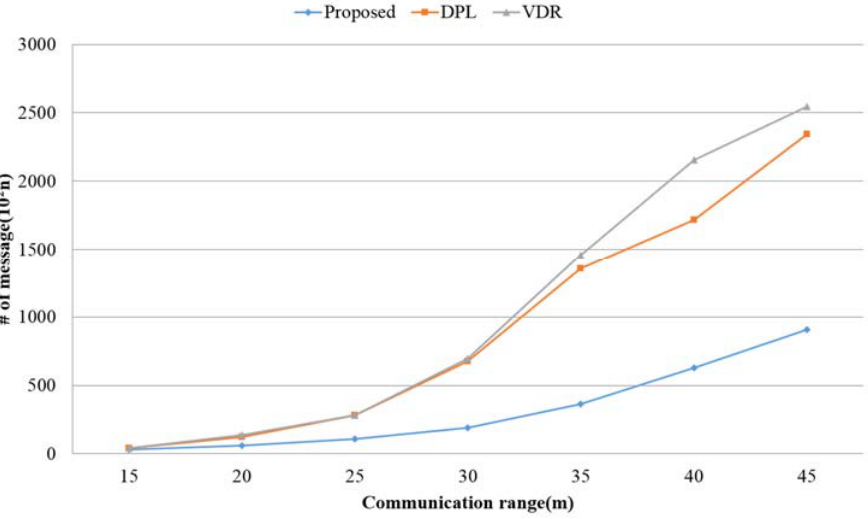
Figure 10. Number of messages generated according to communication range.